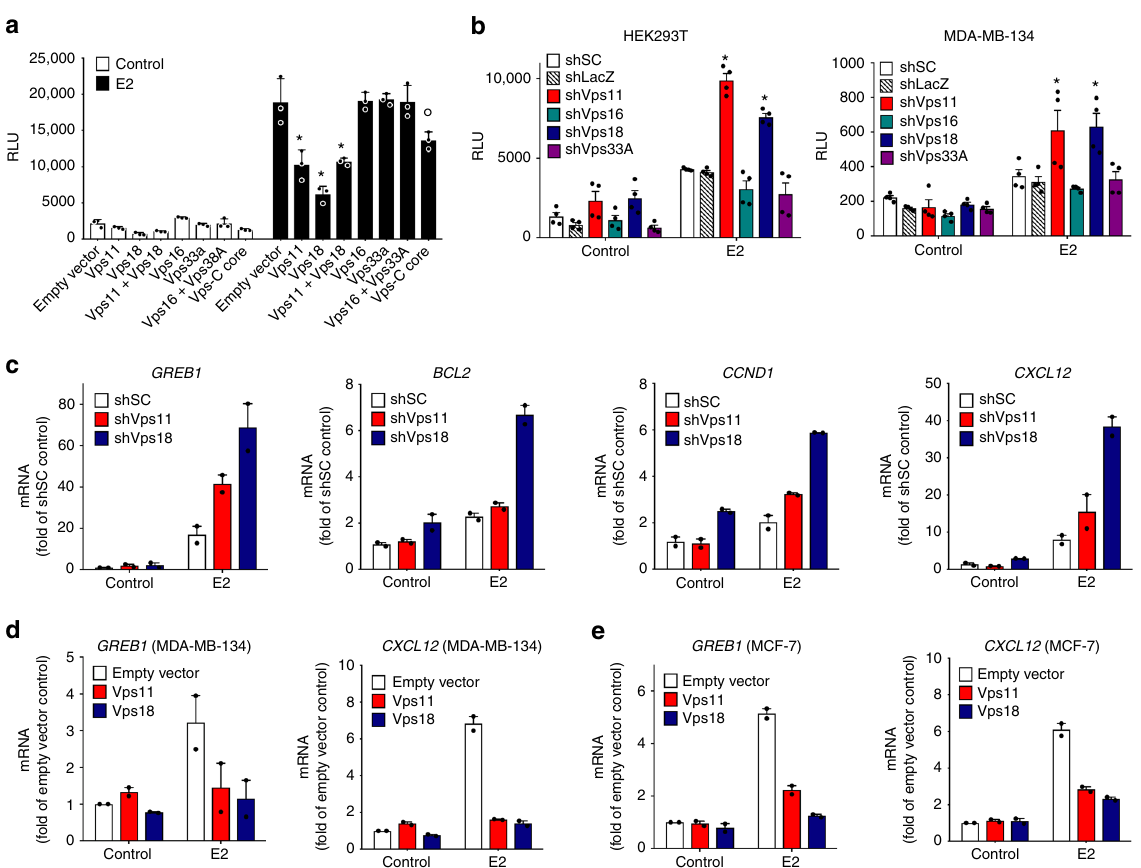
Fig. 3 ER α transcriptional activity is speci fi cally repressed by Vps11/18. a ER α reporter assay with HEK293T cells overexpressing different combinations of Vps-C core components and treated or not with E2 (mean ± s.e.m. with n ≥ 3 biologically independent experiments). b ER α reporter assays with HEK293T or MDA-MB-134 breast cancer cells infected with lentiviral shRNA constructs for the knock-down of Vps-C core components and treated or not with E2 (mean ± s.e.m. with n ≥ 3 biologically independent experiments); see Supplementary Fig. 4b for the results with a second set of shRNA constructs. c – e Quantitative RT-PCR analysis of the mRNA levels of ER α target genes in MDA-MB-134 ( c , d ) or in MCF-7 cells ( e ) (mean ± s.e.m. with n = 2 biological independent experiments). Asterisks indicate signi fi cant differences with the corresponding negative controls with p -values < 0.05; the dot above the bar in a indicates a difference with a p -values of 0.05 – 0.06. Statistical signi fi cance was determined with unpaired and two-sided Student ’ s t -tests. Source data are provided as a Source Data fi